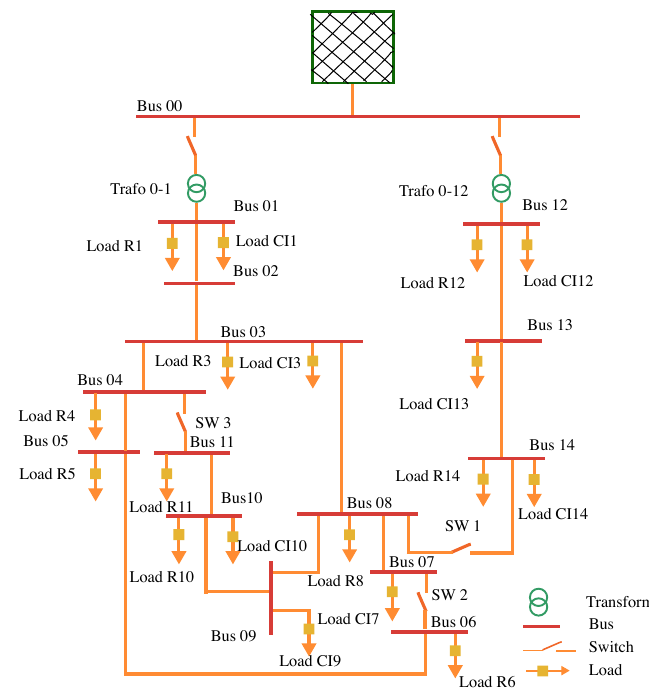
Figure 3. CIGRE medium voltage distribution network benchmark